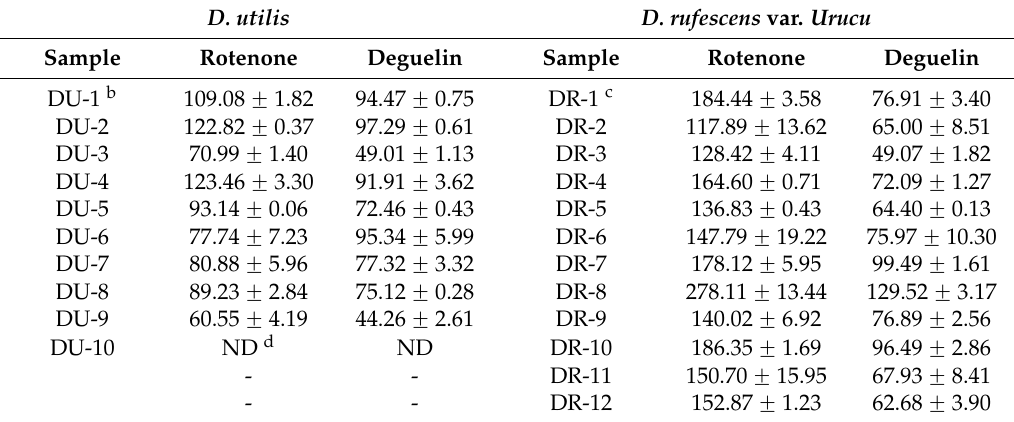
Table 3. Concentrations of rotenone and deguelin in the species Deguelia utilis and D. rufescens var. urucu . Values presented in µ g of rotenoids per gram of DGR ˘ CV a